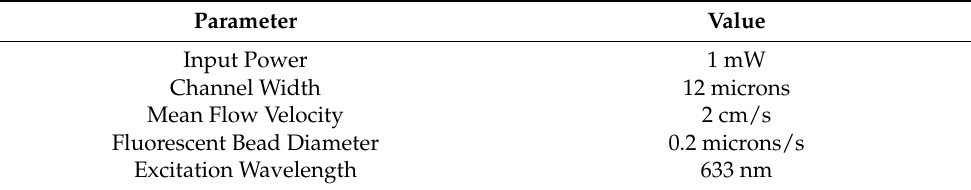
Table 1. Design Parameters.